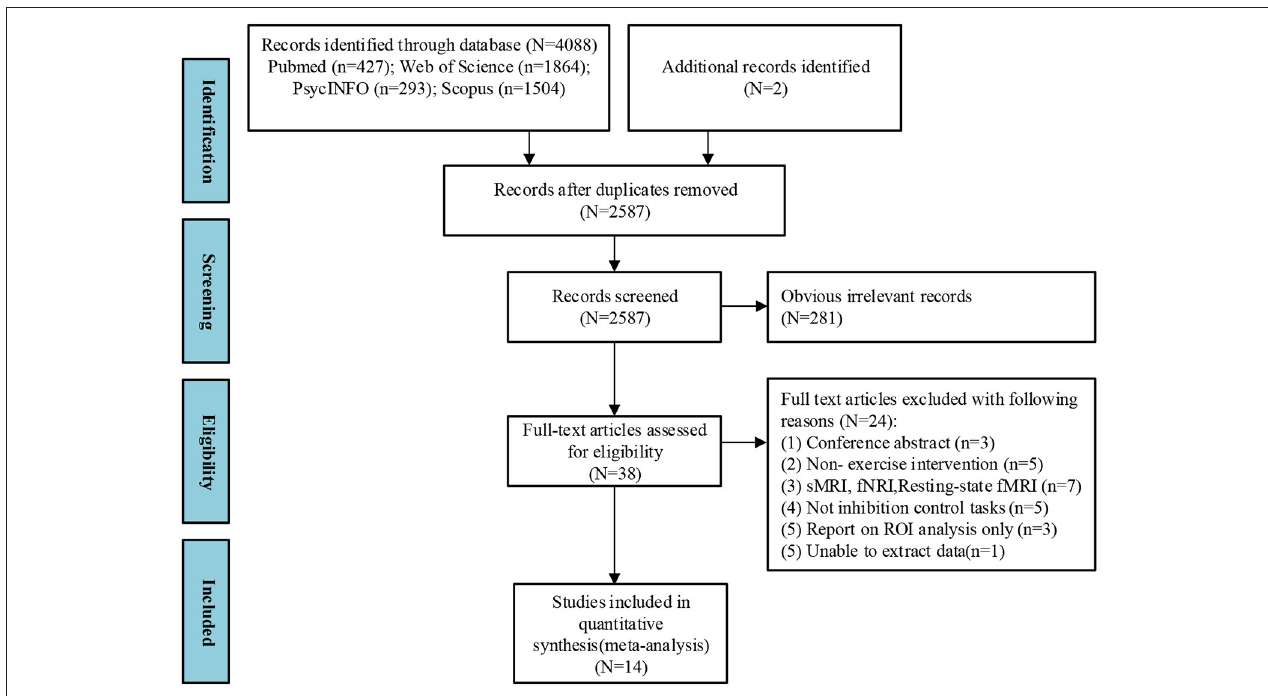
FIGURE 1 | PRISMA flow diagram of selected studies. Multi-step search process shows the number of studies screened and those that meet the inclusion